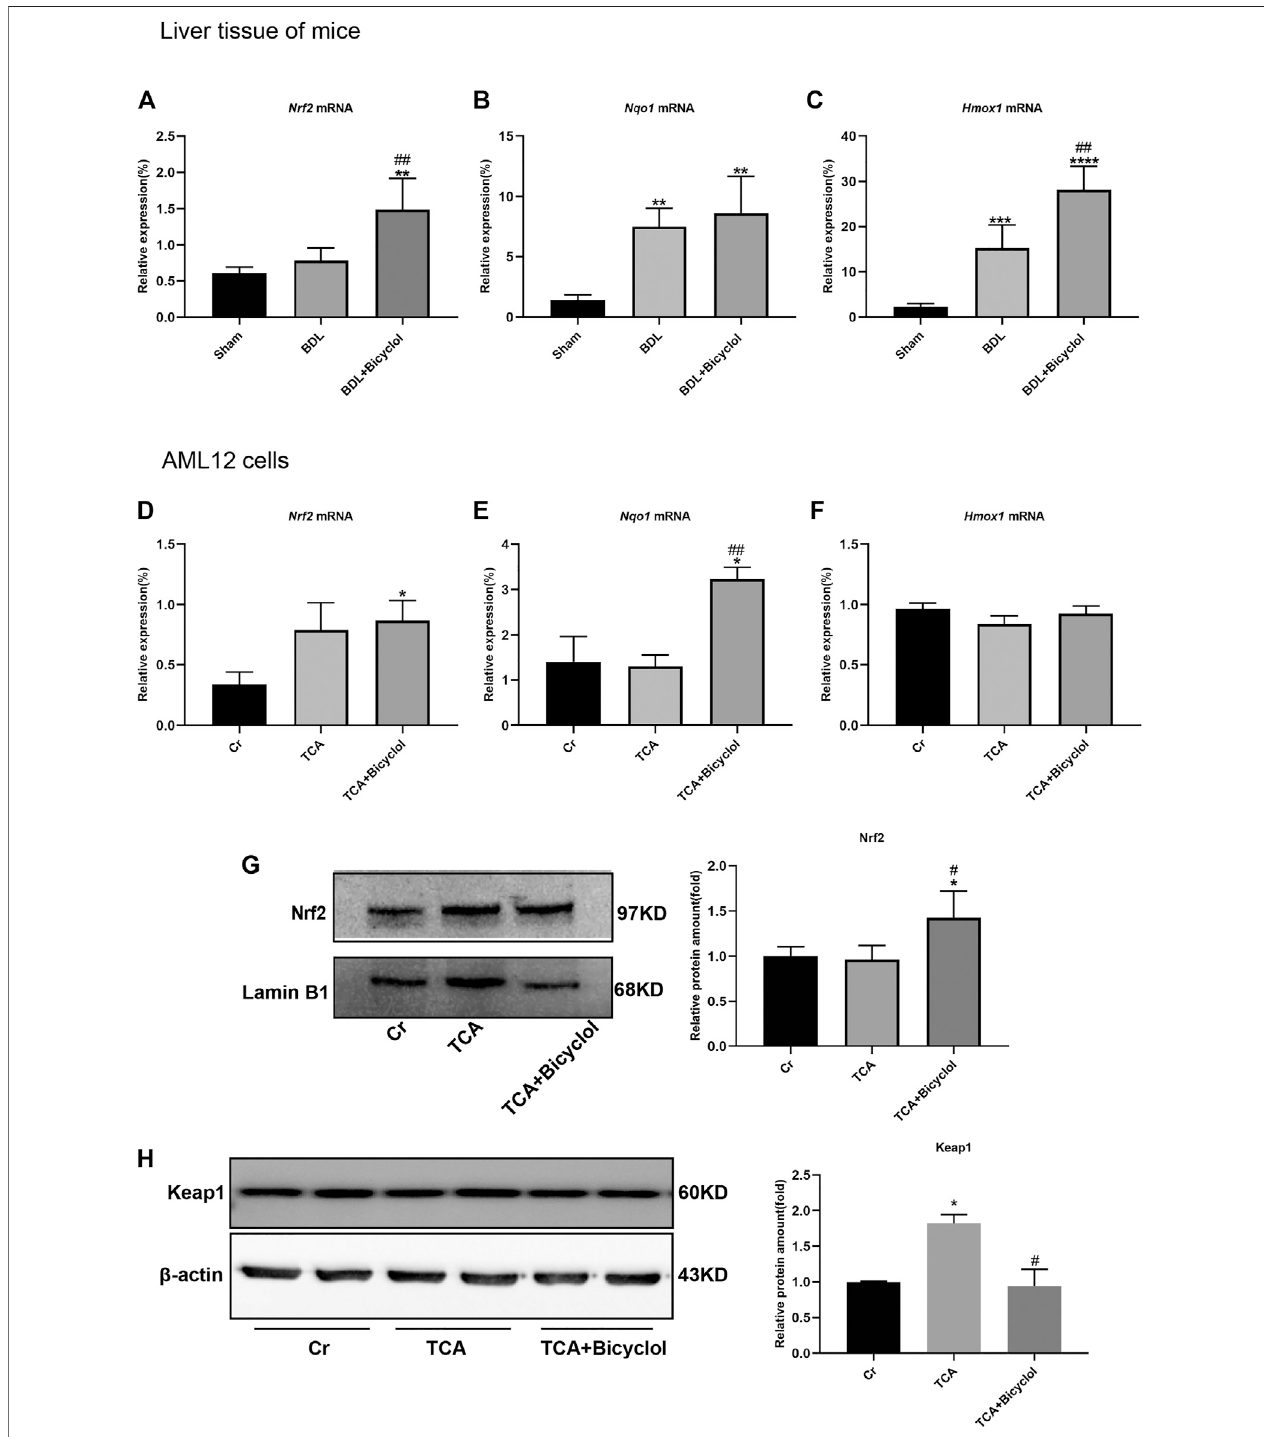
FIGURE 6 | Effects of bicyclol on Nrf2 and its target genes. (A – C) The mRNA levels of Nrf2, Nqo1, Hmox1 in BDL and bicyclol treatment mice. (D – F) The mRNA levelsofNrf2,Nqo1,Hmox1;TheproteinlevelsofNrf2 (G) andKeap1 (H) inAML12cellsafterTCAandbicyclolexposure.Datesareexpressedasmean ± SD.* p < 0.05, ** p < 0.01, *** p < 0.001, **** p < 0.0001 vs. sham or Cr; # p < 0.05, ## p < 0.01 vs. BDL or TCA.